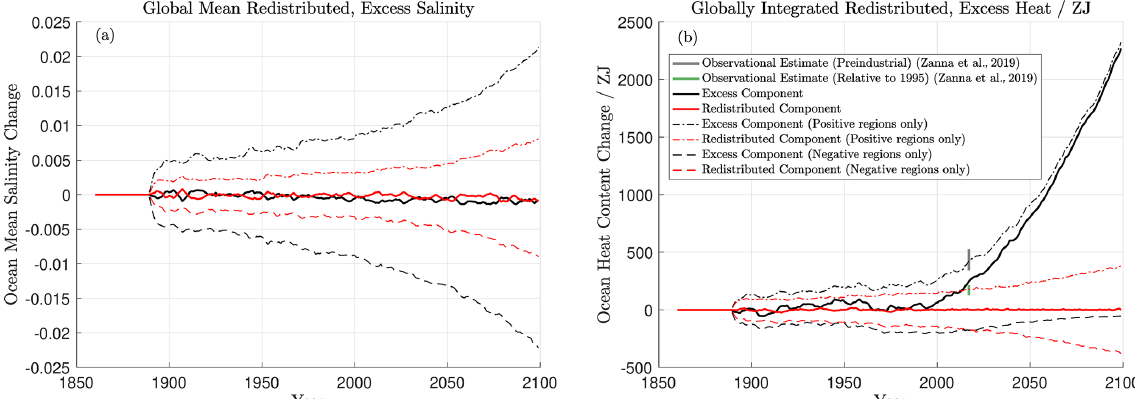
Figure 5. Global mean excess and redistributed salinity (a) as well as globally integrated excess and redistributed heat (b) . Excess components are shown in black and redistributed components in red. The integrals of only the positive and negative regions are also shown (thin dashed lines). Climate change and control runs use the same first 30 years of forcing, so values are by definition zero here: the jump in 1890 represents the initial divergence of states. Observational estimates of global ocean heat uptake from Zanna et al. (2019) are also shown in panel (b)